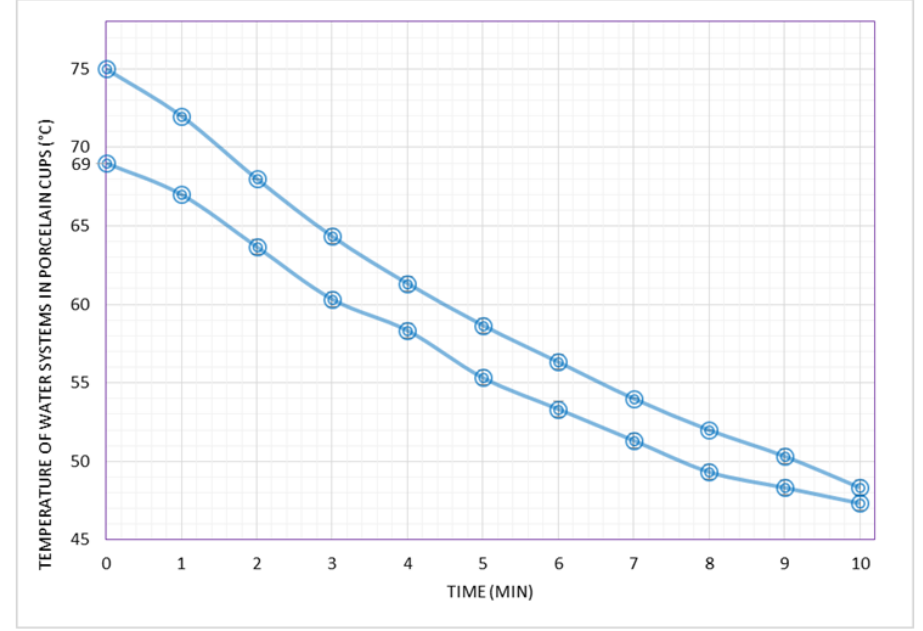
Figure 2. Cooling behaviors (temperature as a function of time) of hot water systems from 75 °C and 69 °C, both in 50 mL porcelain cups and at a constant ambient temperature of 25 °C. Temperatures of the water systems were collected in one minute intervals up to 10 min. Point values are shown as mean of 3 repetitions ± standard deviations of each experiment and the coefficient of variation never exceeded 1.0%.